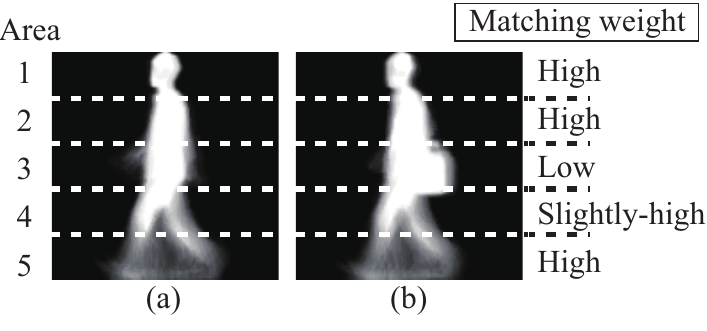
Figure 1. ( a ) An example of average images in the database; ( b ) An example of average images of subjects with a shoulder